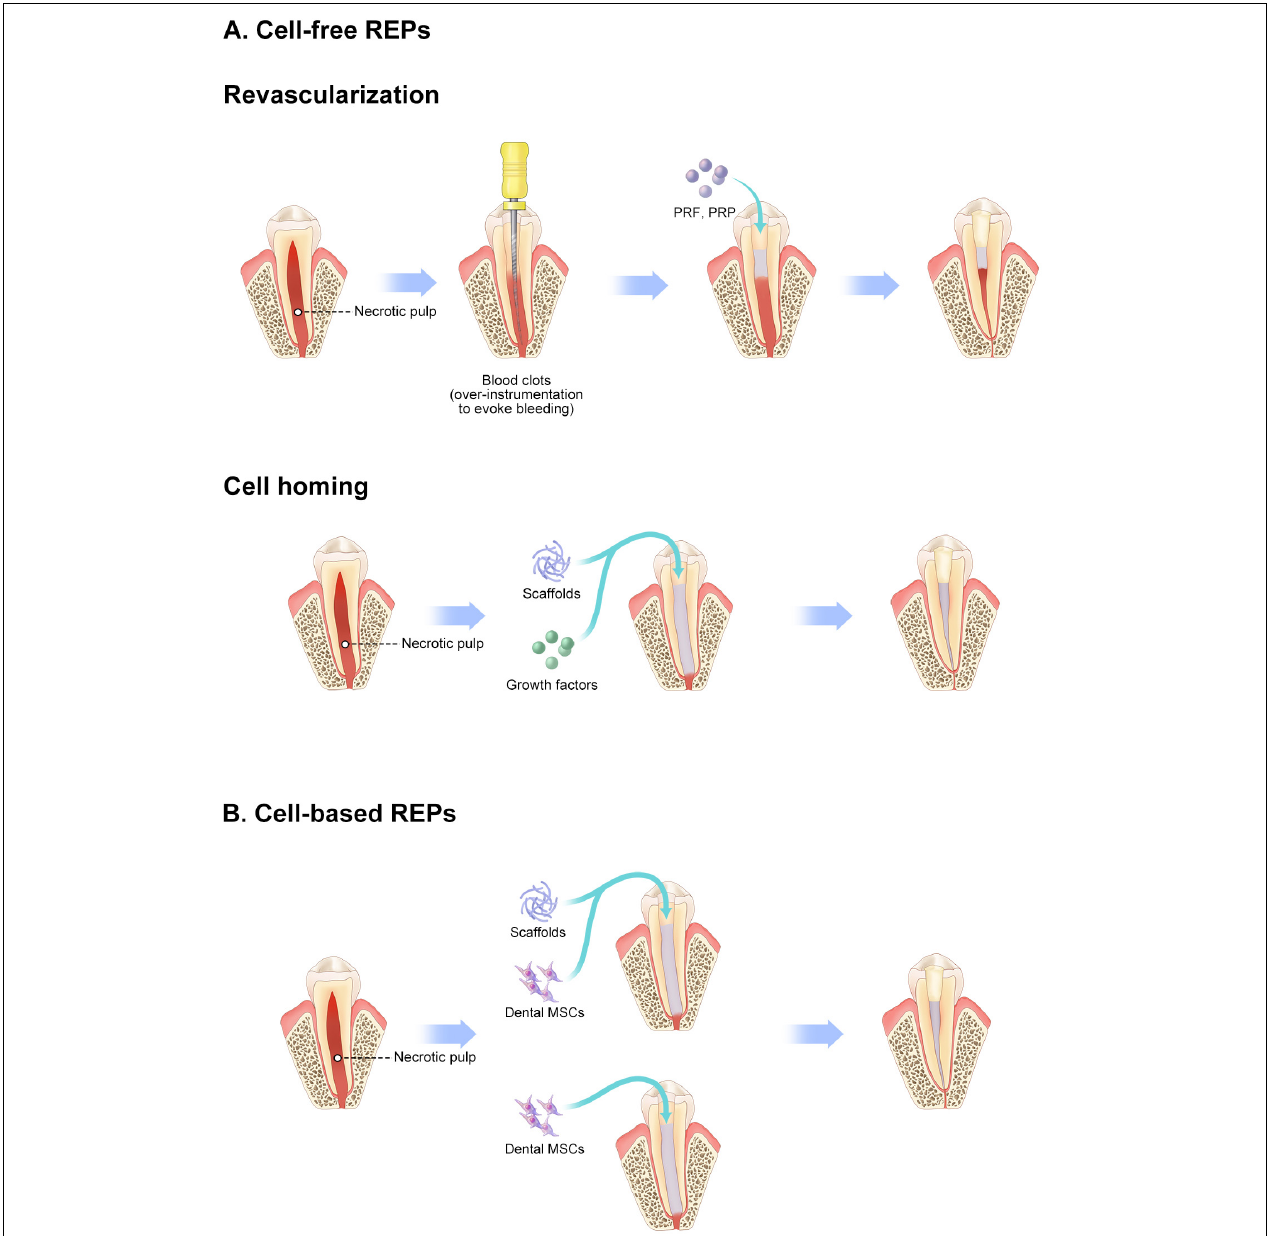
FIGURE 2 | Schematic diagram of REPs. (A) Cell-free REPs. (B) Cell-based REPs. REPs, regeneration endodontics